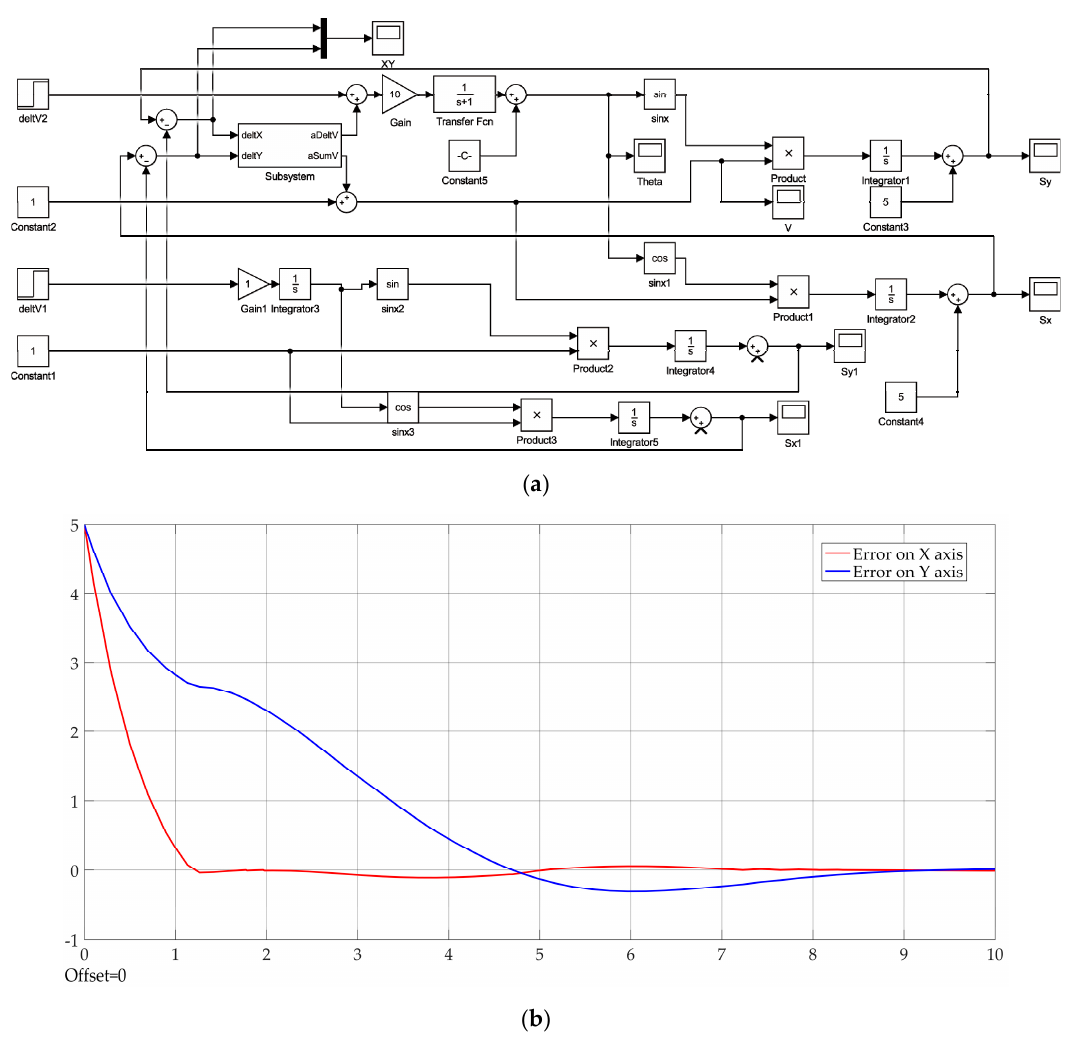
Figure 7. The simulation in Simulink and convergence of results for oblique linear motion. ( a ) Simulink simulative model graph; ( b ) The model reaches a steady convergent state.